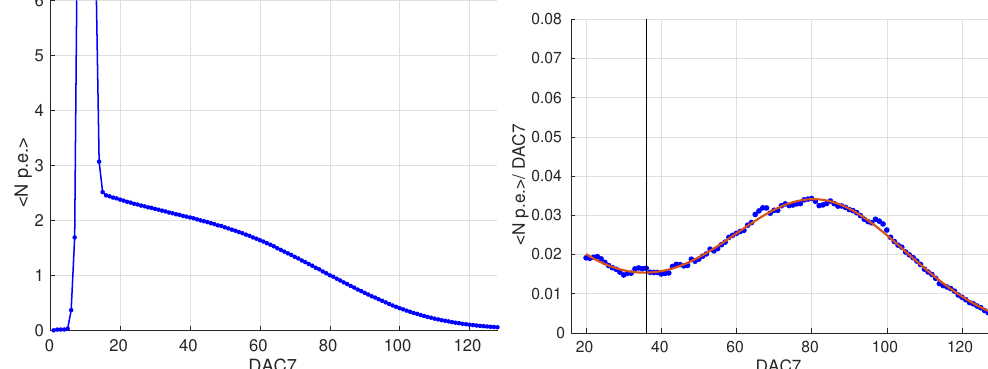
Figure 8. The black vertical line in the right panel corresponds to the optimized threshold.